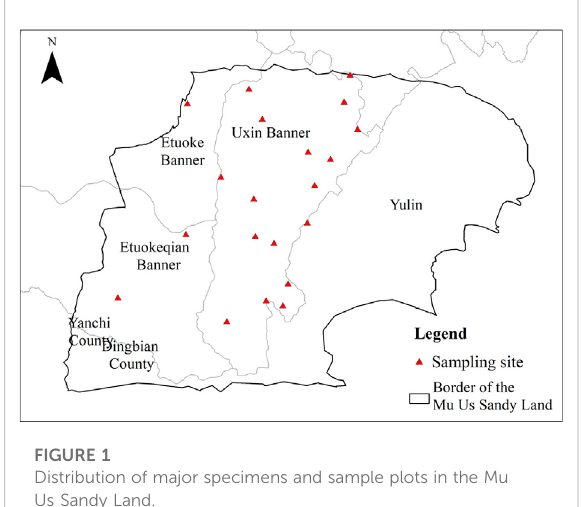
Distribution of major specimens and sample plots in the Mu Us Sandy